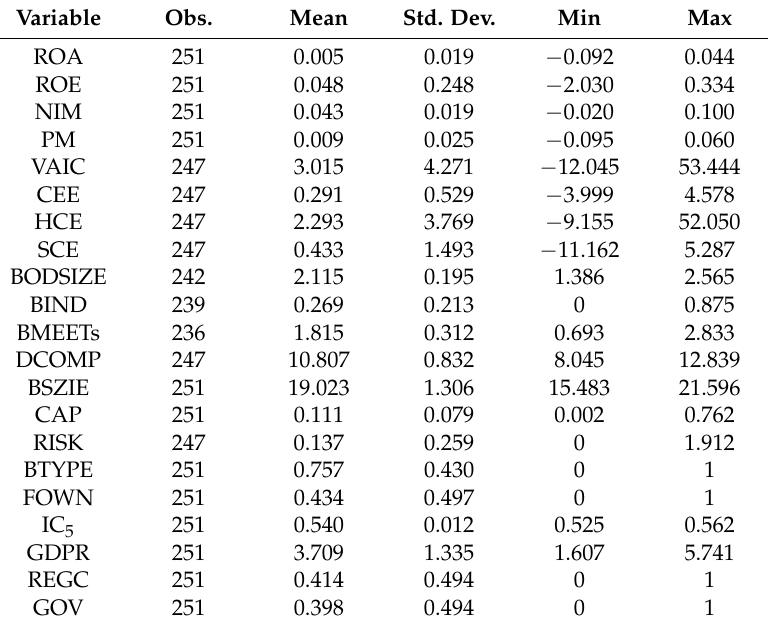
Table 5. Summary